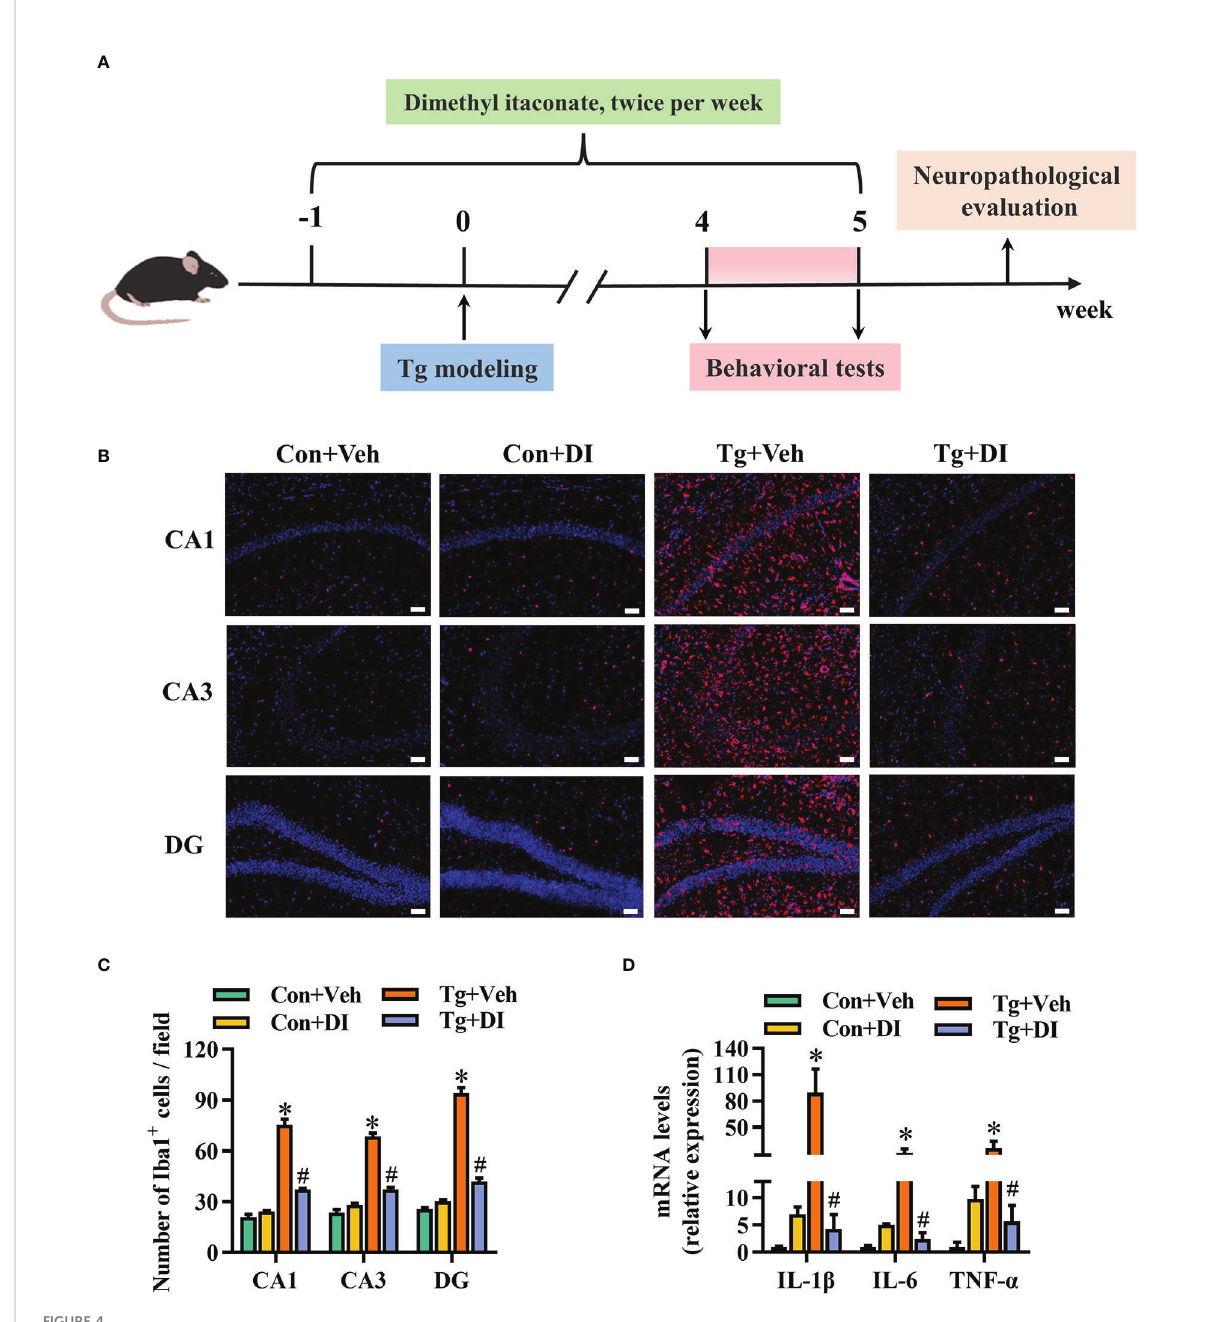
FIGURE 4 Dimethyl itaconate ameliorates the neuroin fl ammation in T. gondii infected mice. (A) Schematic timeline for DI treatment on cognitive de fi cits induced by T. gondii infection in mice. (B) Representative immuno fl uorescent staining of the Iba-1 + cells in CA1, CA3 and DG of the hippocampus ( n = 3). (C) The quanti fi cation of Iba-1 + cells number in CA1, CA3 and DG of the hippocampus ( n = 3, 10 images per mouse per region, scale bar: 50 m m). (D) The mRNA expression of IL-1 b , IL-6 and TNF- a in the hippocampus ( n = 3). Con+Veh, control mice with vehicle control treatment; Con+DI, control mice with DI treatment; Tg+Veh, T. gondii infected mice with vehicle control treatment; Tg+DI: T. gondii infected mice with DI treatment. Values are mean ± SEM. * P <0.05 vs. control (Con+Veh). # P < 0.05 vs. T. gondii infected